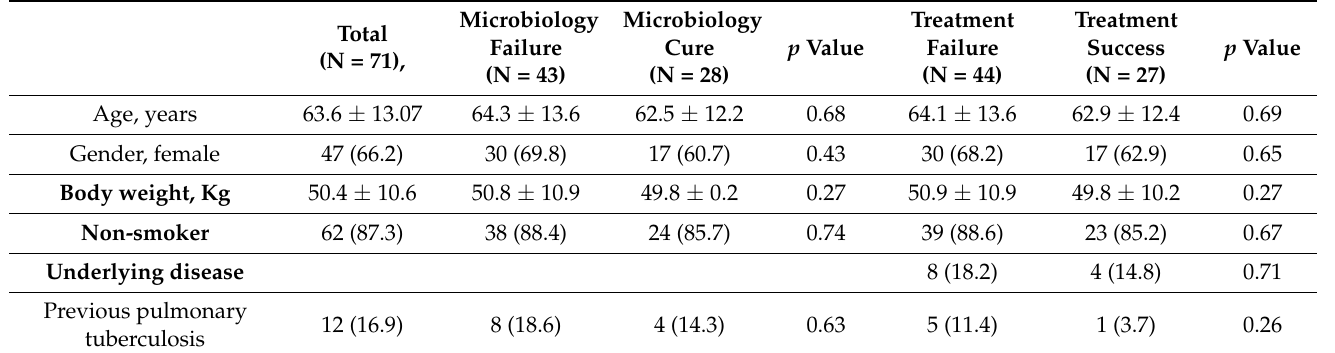
Table 1. Demographics and clinical characteristics of patients with Mycobacterium abscessus complex lung